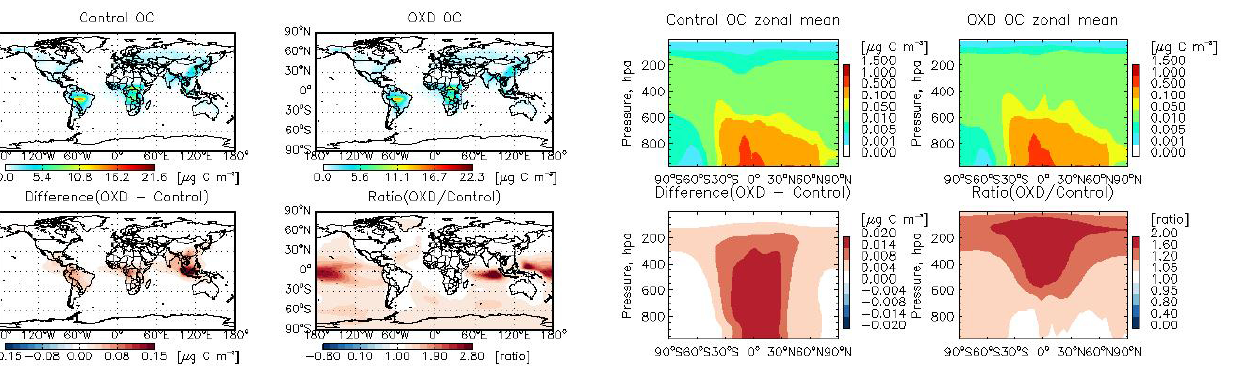
Fig. 3d. Same as Fig. 3b but for zonal mean.